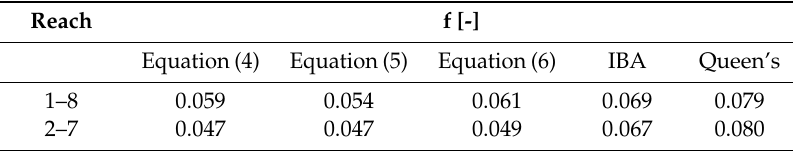
Table 4. Friction factors f according to di ff erent